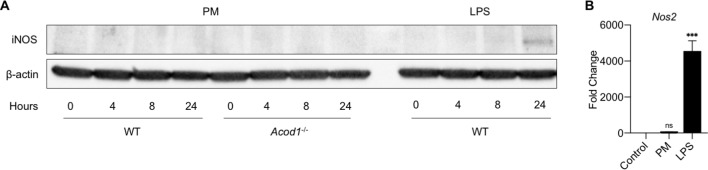
Inducible Nitric Oxide Synthase (iNOS) is induced by LPS but no by PM.(A) Western blot of BMDMs treated with PM (20 µg/cm2) or LPS (100 ng/ml) for 0, 4, 8 or 24 hours. iNOS protein is not evident with PM treatment at any time point, but it is detectable with 24 hours of LPS treatment. (B) qPCR of BMDMs treated with PM or LPS for 24 hours. LPS significantly induces expression of Nos2 mRNA, the gene encoding iNOS protein. Significance between control and treatment groups was analyzed with one-way ANOVA corrected with Bonferroni’s post hoc test for multiple comparisons, n = 4; *p<0.05, **p<0.01, ***p<0.001.